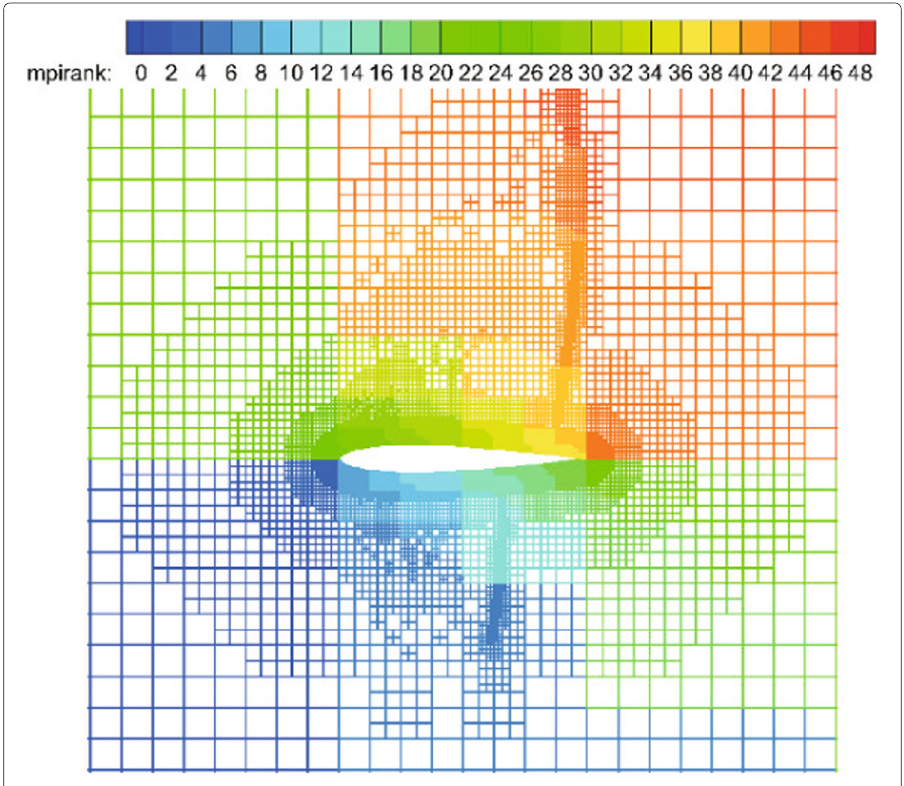
Fig. 12 Adapted mesh for the problem of inviscid flow over a single NACA0012 airfoil (colored by the process number)